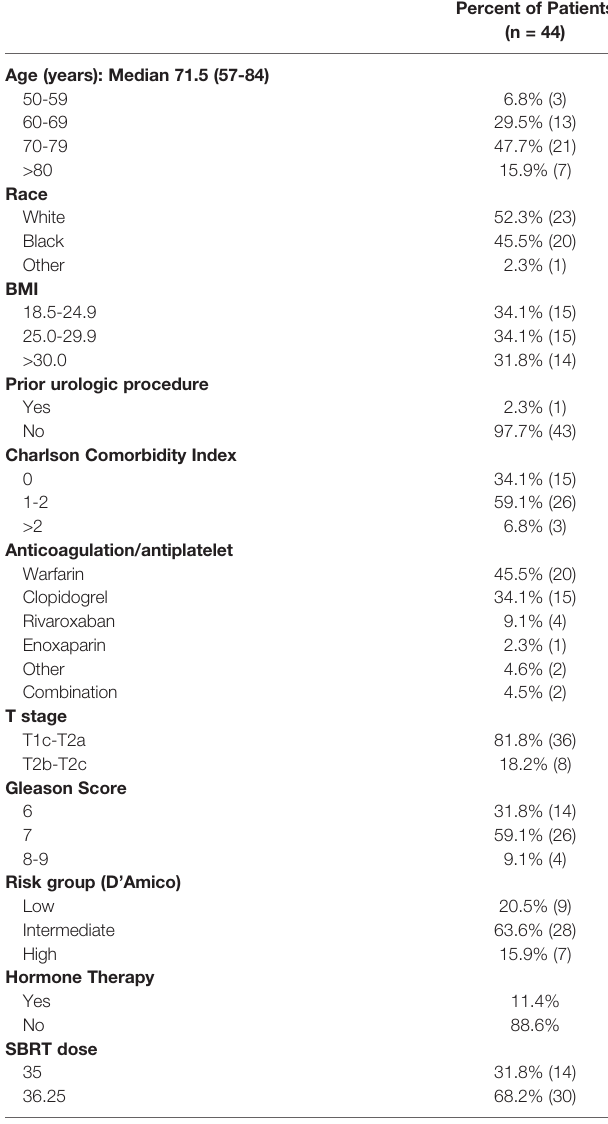
TABLE 1 | Patient characteristics and treatment.